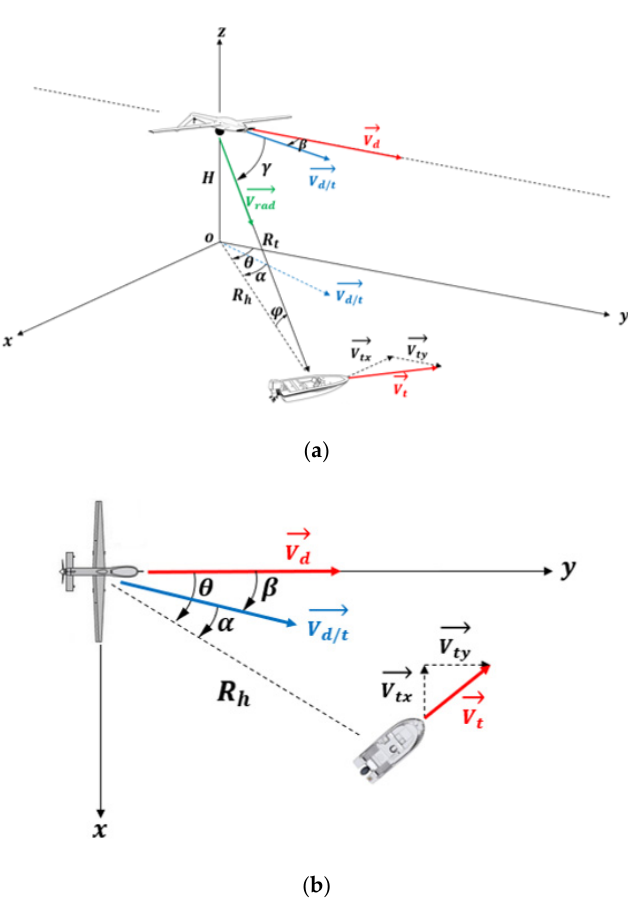
Figure 12. Geometrical configuration of the radar and a target: ( a ) 3D geometry of radar; ( b ) periodic scanning of radar antenna.